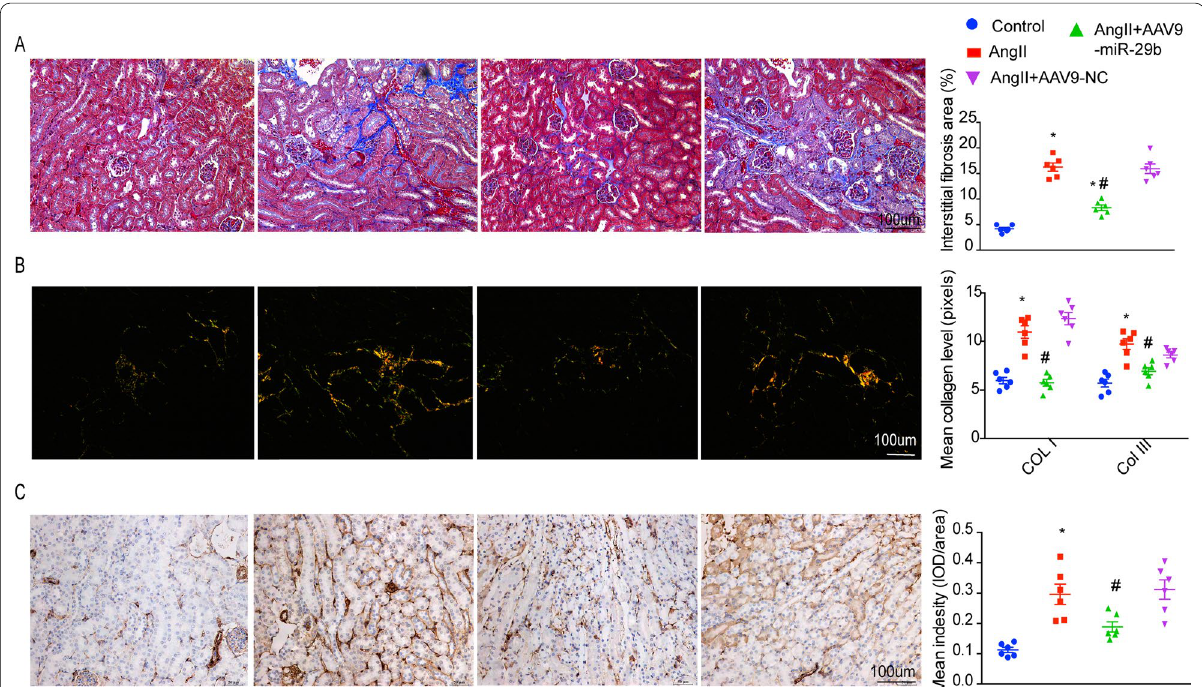
Fig. 3 Effects of rAAV9‑miR‑29b transduction on fibrotic changes in AngII‑induced kidneys. A Representative Masson staining of kidney sections in each group quantitative analysis of fibrotic areas. Areas with positive blue staining show collagen fibers. Magnification, 200. B Representative sirius × red staining of kidney sections and quantitative analysis of fibrotic areas. Area with yellow stain show collagen type I (COL I) and green stain show collagen type III (COL III). Magnification, 200. C Representative images of alpha‑smooth muscle actin (a‑SMA) immune staining of kidney among × the groups(six high‑power fields counted per group). Magnification, 200. Values are mean SEM, n 6. * P < 0.05 compared with control group. × ± = # P < 0.05 compared with rAAV9‑negative control. Scale bar 100